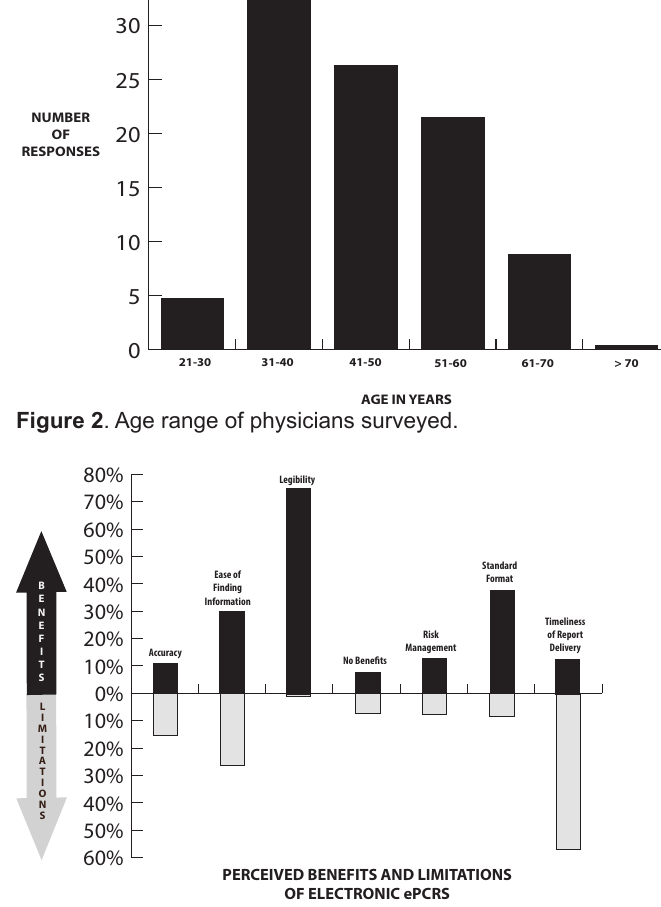
Figure 3 . Respondents’ report of perceived benefits and limitations of electronic patient care reports.